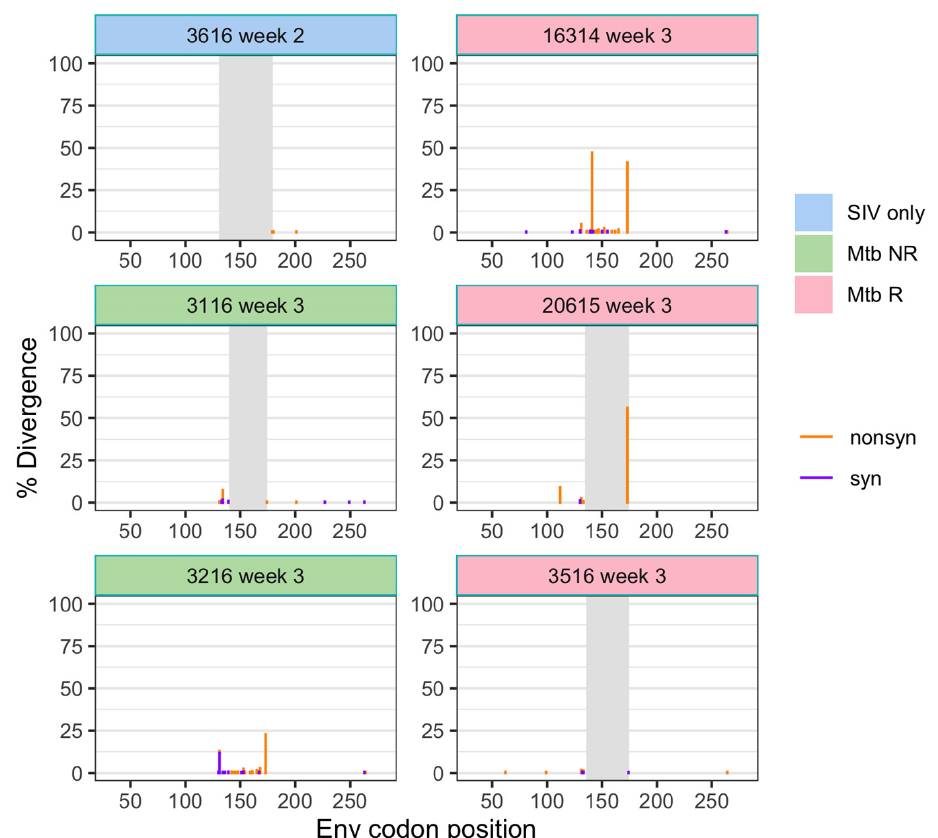
Figure 3. Divergence (from the stock consensus) of SIV env in plasma samples following transmission. Divergence is shown separately for nonsynonymous and synonymous changes at each position. Gray shading indicates the region missing in some of the sequences.